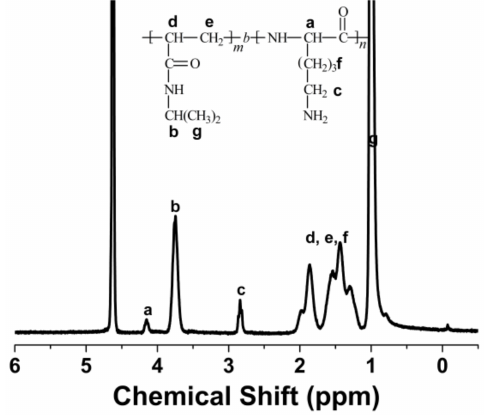
Figure 1. 1 H-NMR spectrum of PNIPAM 315 - b -PLL 25 in D 2 O at 25 ◦